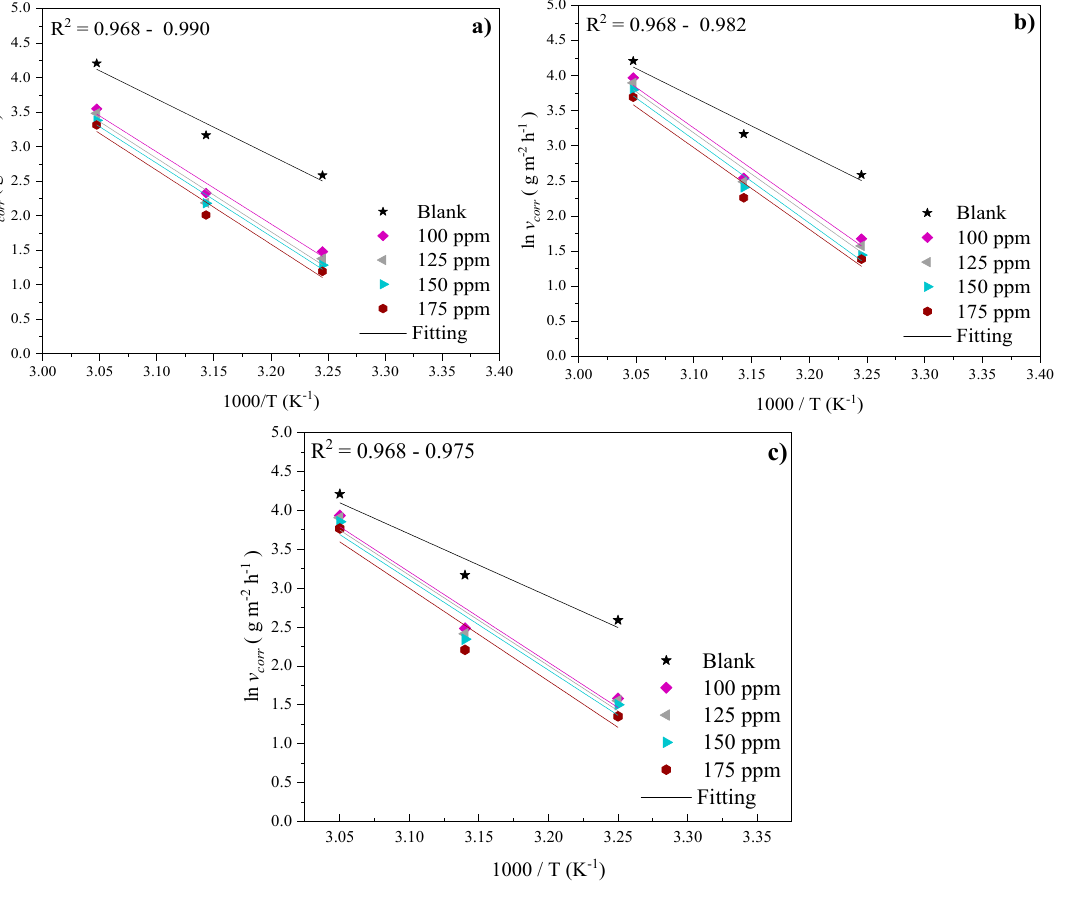
Figure 13. Arrhenius equation for API 5L X60 steel exposed to 1 M H 2 SO 4 in the absence and presence of ( a ) Poly[VIMC4][Im], ( b ) Poly[VIMC2][Br] and ( c ) Poly[VIMC4][Br]. Table 6 shows that E a augmented from 68.00 kJ/mol in the H 2 SO 4 solution in the ab- sence of CIs to 101.00 kJ/mol in the presence of PILs. According to the literature, if the E a values of the system in the presence of CIs are higher than those of the blank, the behavior can be associated with a physisorption process or also with the diminution of the inhibitor adsorption on the metallic surface as a consequence of the temperature increase; on the contrary, if the 𝐸 𝑎 values are lower, the charge transfer from the inhibitor to the metallic surface to form coordinate covalent bonds, that is to say through a chemisorption process, is suggested [69]. An increase in the temperature of the acid medium implies the acceleration of the metal dissolution process and then higher E a values in the presence of CIs suggest that a higher energy physical barrier is formed by the electrostatic adsorption of Poly[VIMC4][Im], Poly[VIMC2][Br] and Poly[VIMC4][Br] molecules on the steel surface [59,70]. Such a physical barrier made of PILs limits the charge and mass transfer in the metallic interface [18]. On the other hand, A is related to the collision frequency between CI molecules and the acid medium and an increase in these values in the presence of PILs is associated with the increase in the system kinetic energy by e ff ect of T . Table 6. Kinetic parameters of the inhibition process of API 5L X60 steel in 1 M H 2 SO 4 with and without CIs.